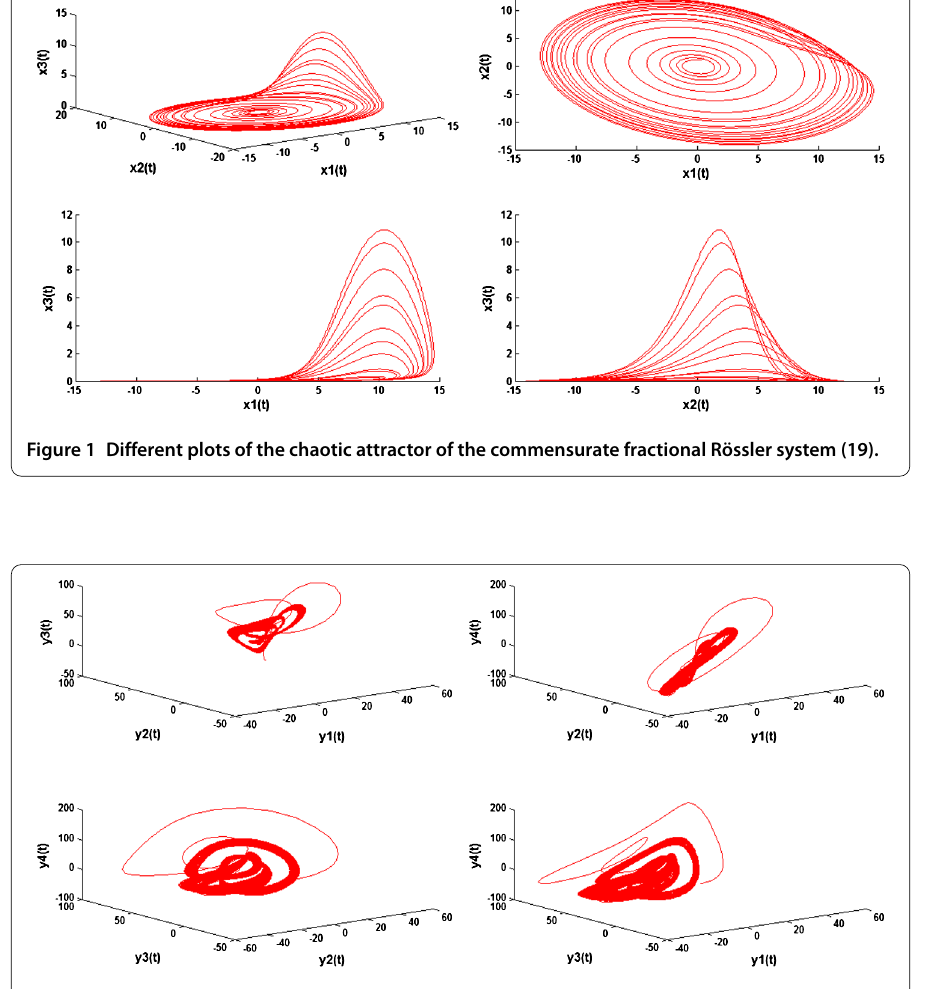
The hyperchaotic fractional-order commensurate Chen system is considered as the slave system